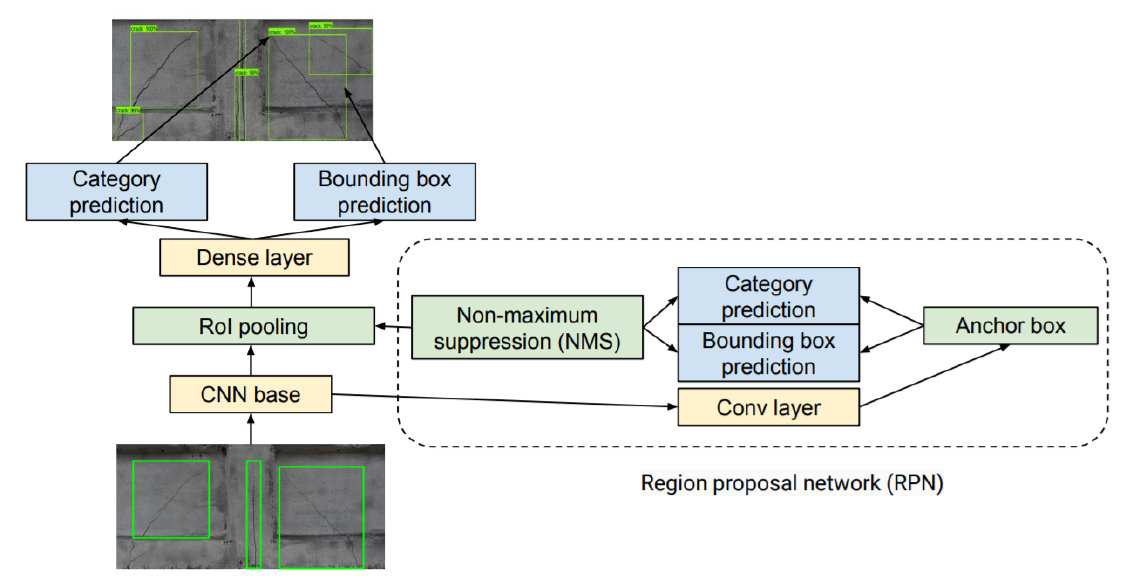
Figure 3. Diagram of the Faster-R-CNN model